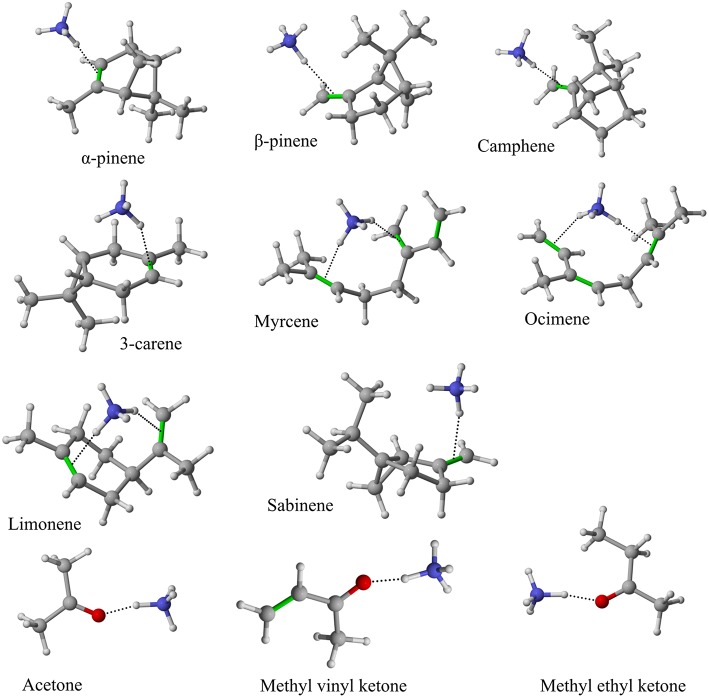
Geometries of the NH4+-A cluster ions for all investigated analytes. Color coding: gray = C, white = H, red = O, blue = N. The green bonds indicate C = C double bonds in the analytes.